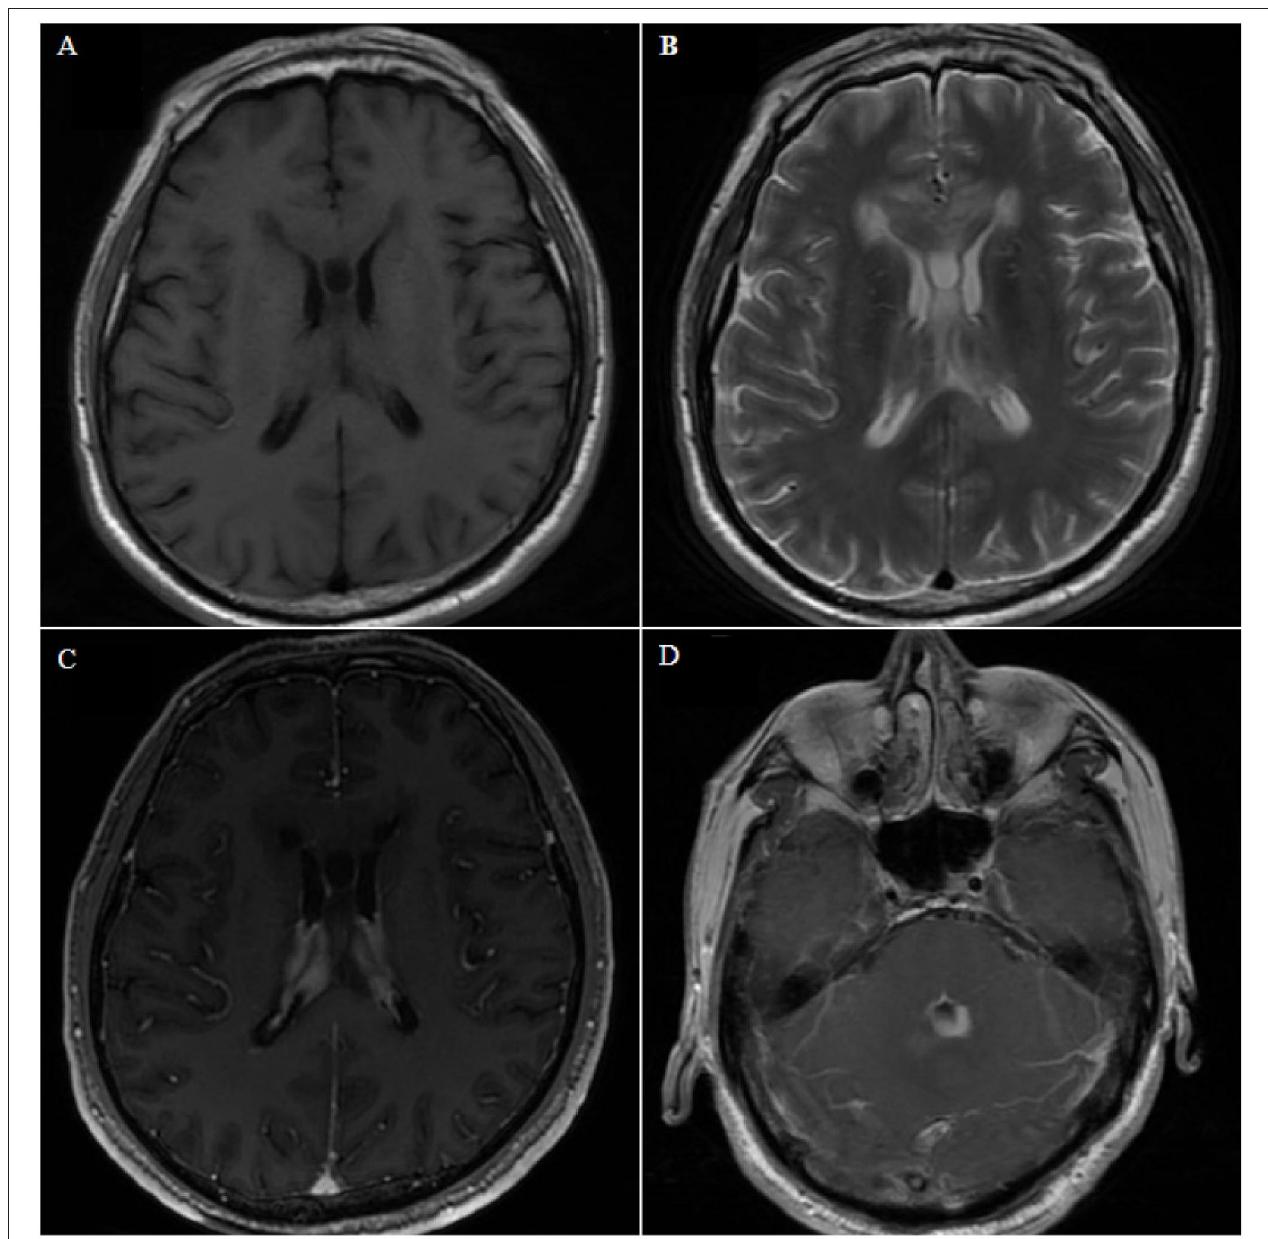
FIGURE 4 | Case 8. Axial magnetic resonance image showing bilateral and fourth ventricle lesions, diffuse growth along the choroid plexus and ventricle wall, low signal on T1- and T2-weighted images (A,B) , and homogeneous enhancement on contrast-enhanced T1-weighted images (C,D) .